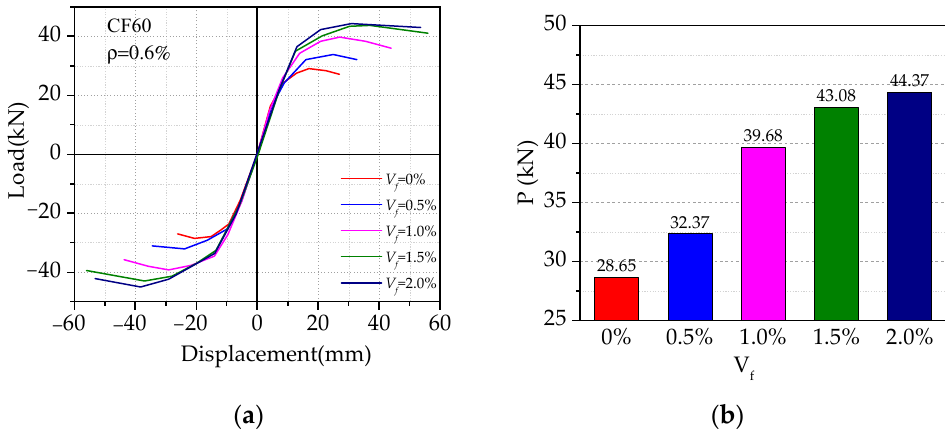
Figure 12. Effect of steel fiber volume ratios: ( a ) comparison of skeleton curve; ( b ) comparison of peak load.